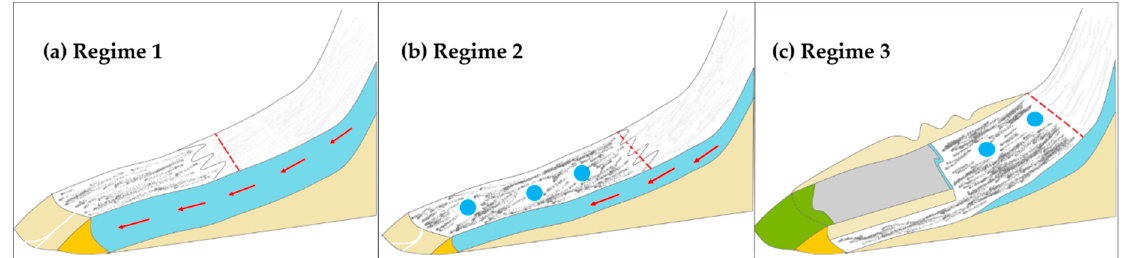
Figure 11. Diagrammatic representation of debris-covered glacier regimes. ( a ) Regime 1: active ice flow; ( b ) Regime 2: downwasting ice; ( c ) Regime 3: calving retreat. Red arrows represent basal flowing, red dotted lines represent the equilibrium line altitudes (ELAS), blue circles represent small lakes, blue shadow represents the basal surface, light orange shadow represents the terrain, orange shadow represents the surface at the terminal of a glacier, the white strips at the terminal in ( a ) and ( b ) represent the flow of glacial melting, gray shading in ( c ) indicates a glacial lake, and green shadow indicates the surface at the terminal of a lake. (modified from Been et al. [2]).